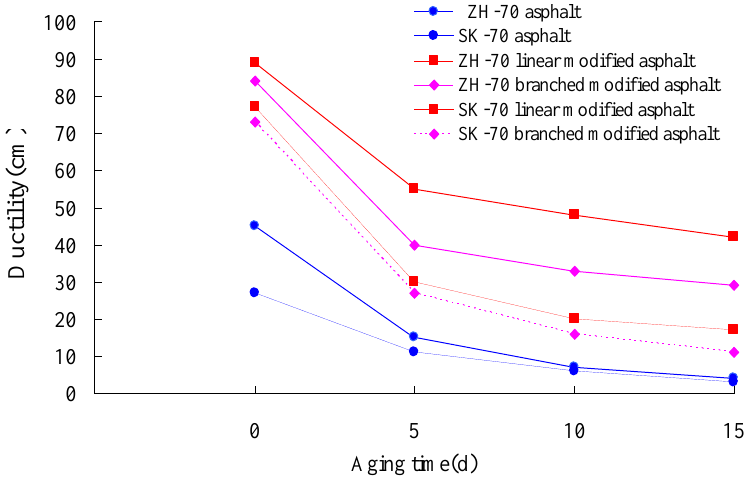
Figure 6. Ductility and aging times for different asphalts.